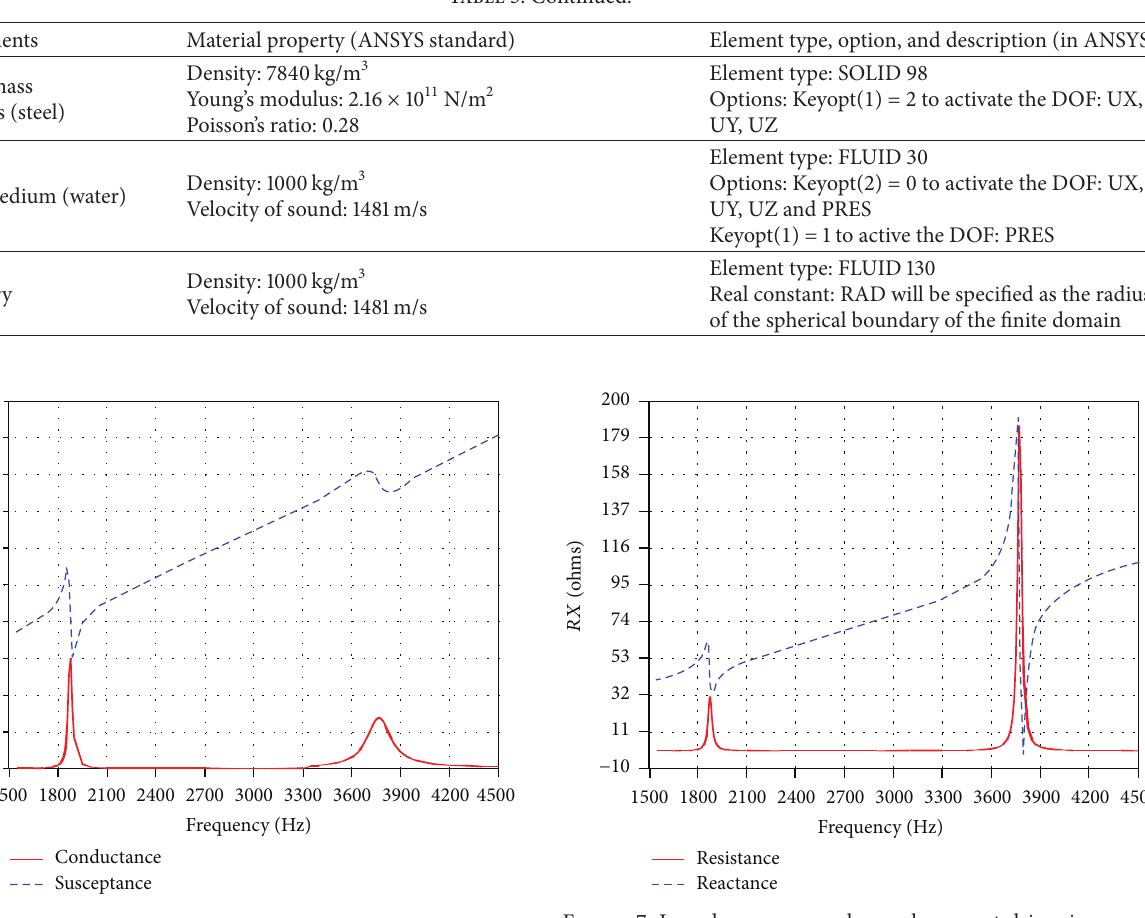
Figure 6: Admittance curves when only voltage drives in piezoelec- tric section (in water, obtained from finite element model).